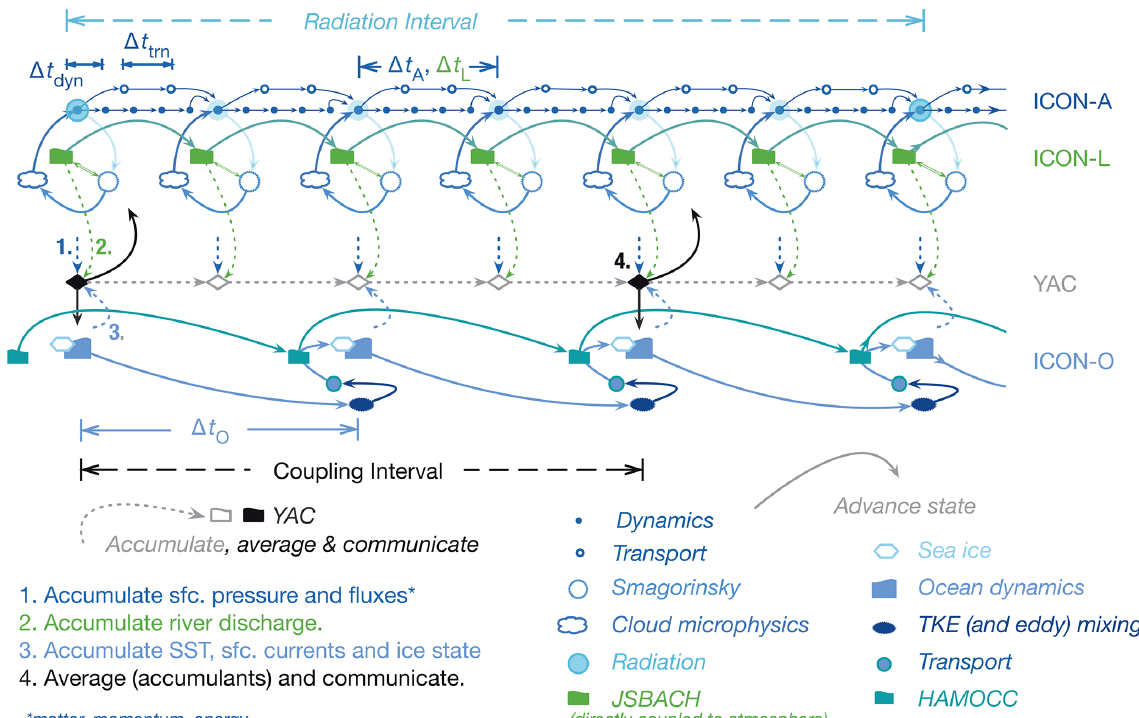
Figure 3. Time stepping in